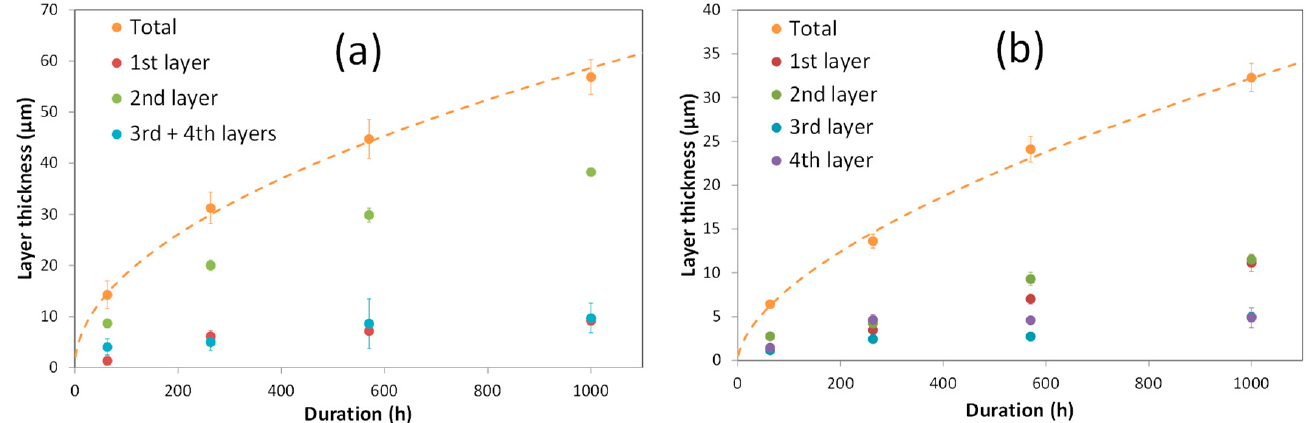
Figure 13. Evolution of the total reaction layer and of each layer’s thicknesses as a function of time at 1200 ◦ C in the Nb/SiC ( a ) and Ta/SiC ( b ) diffusion couples. The 1st, 2nd and 3rd + 4th layers correspond to NbC 1 − x , Nb 5 Si 3 C y and NbC 1 − z + Nb 2 C in the Nb/SiC system, respectively. The 1st, 2nd, 3rd and 4th layers correspond to TaC 1 − x , Ta 5 Si 3 C y , Ta 5 Si 3 and Ta 2 Si in the Ta/SiC system, respectively.